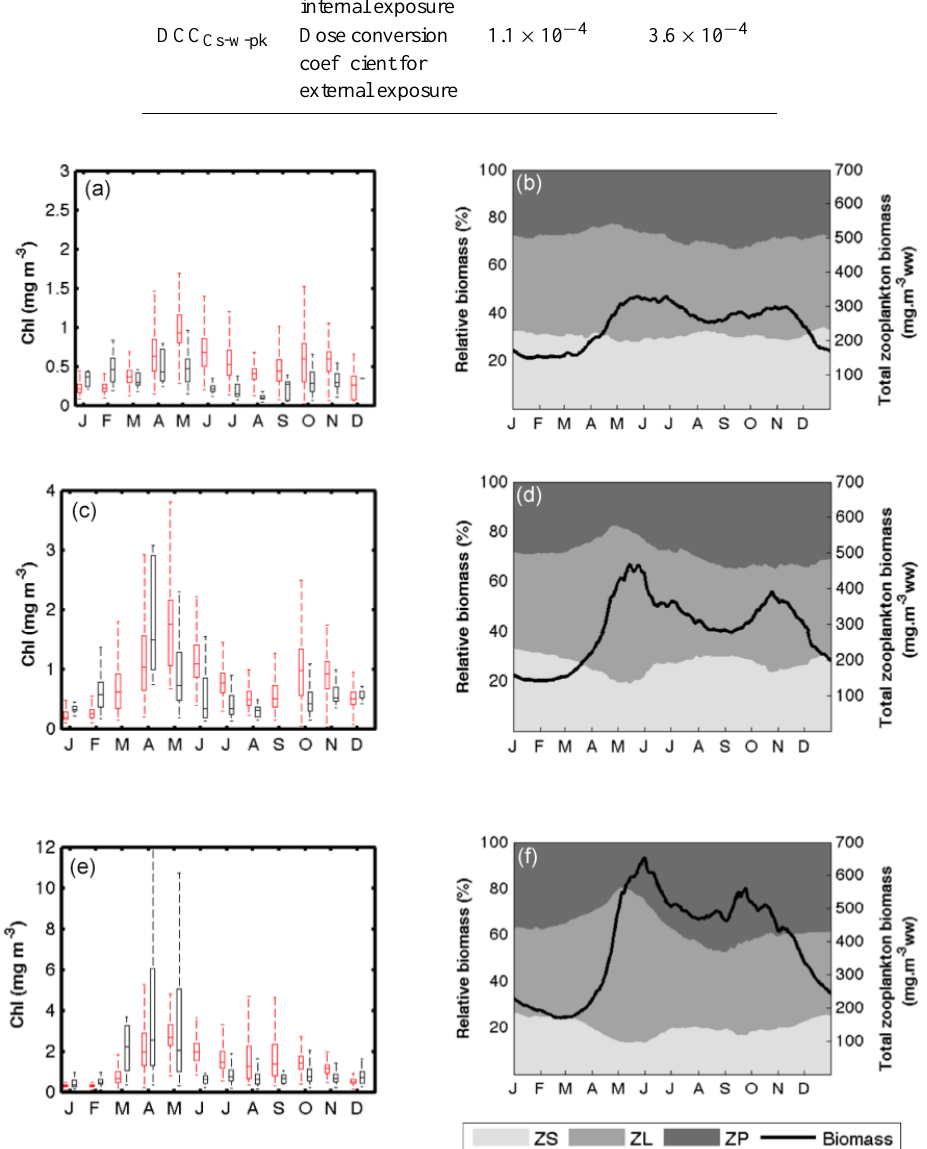
Figure 2. (a, c, e) Climatological seasonal cycle of integrated chlorophyll from in situ data (in black) and model results (in red) aggregated as monthly medians. In situ climatology data is derived from the Japan Oceanographic Data Center (JODC) data set for the period (1990–2010). Model outputs are monthly medians for the period 2011–2012 and represented for the three regional areas described in Fig. 1. (b, d, f) Results of the 2-year simulation of the total zooplankton biomass represented as the spatial median (dark line) and its taxonomic composition in the three regional areas described above: subtropical region (a, b) , transition region (c, d) , subarctic region (e, f) .